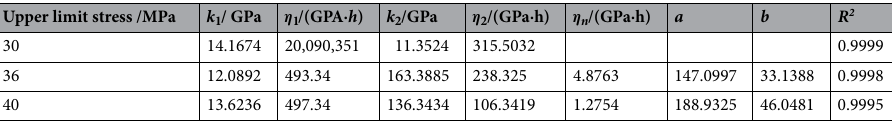
Table 2. Results of fitting parameters for the creep principal structure